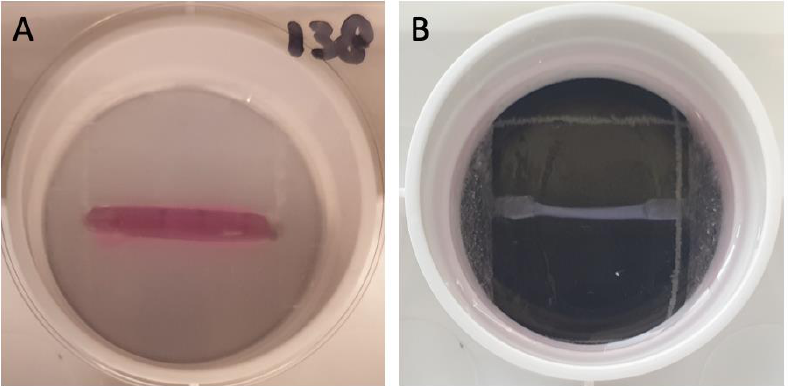
Figure 2. Images of EHM fibers in Flexcell Tissue Train culture plates. Image ( A ) shows the (pink) gel after pipetting in the 6 well Flexcell Tissue Train culture plate, still in the Trough Loader (white bottom) providing the mold for the gel; Image ( B ) shows the EHM fiber between the two anchors after polymerization of the gel. The black and white grid underneath represents 3 cm by 3 cm. The diameter of the well was 3.5 cm.